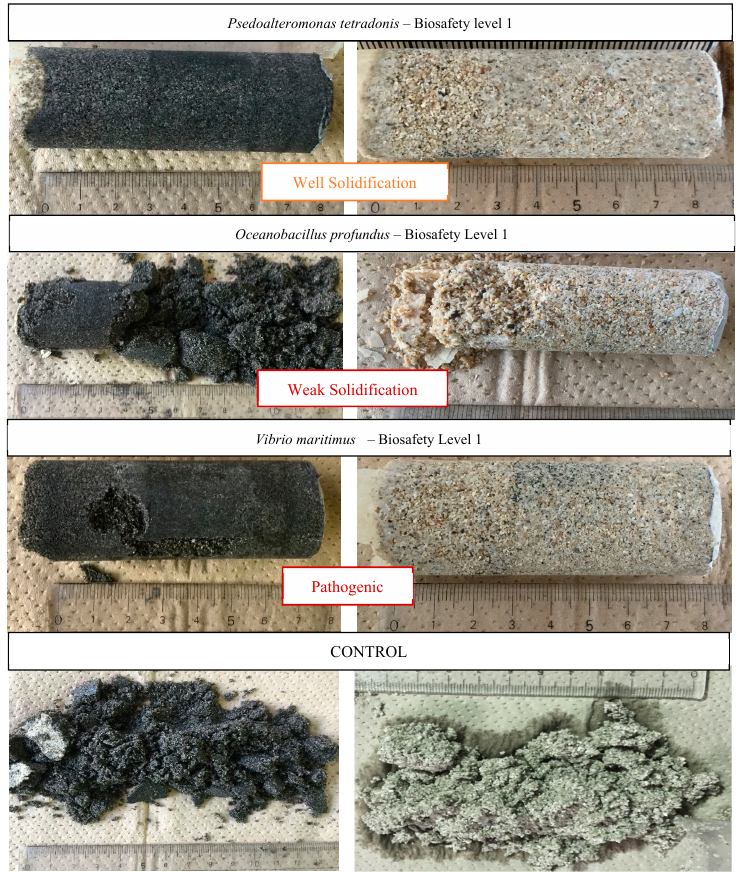
Figure 7. Beach sand treatment test using microbial induced carbonate precipitation after 14 days treatment. Sample with nigrescent color (left) is Quartz silica sand from Parangtritis beach and sample with whitish color (right) is carbonate coarse sand from Krakal-Sadranan beach sand.